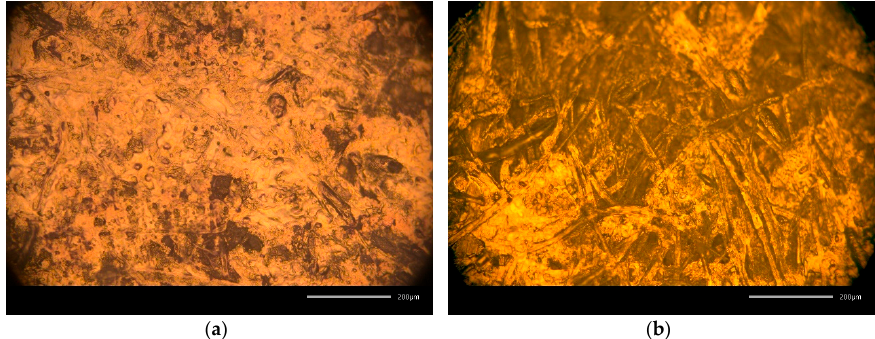
Figure 4. Microscopic images (20×) of the printed, cured and sintered Ag-layer on type 4 ( a ) and type 7 ( b ) paper substrate, the size bar is 200µm in length. Sensors 2020 , 20 , x